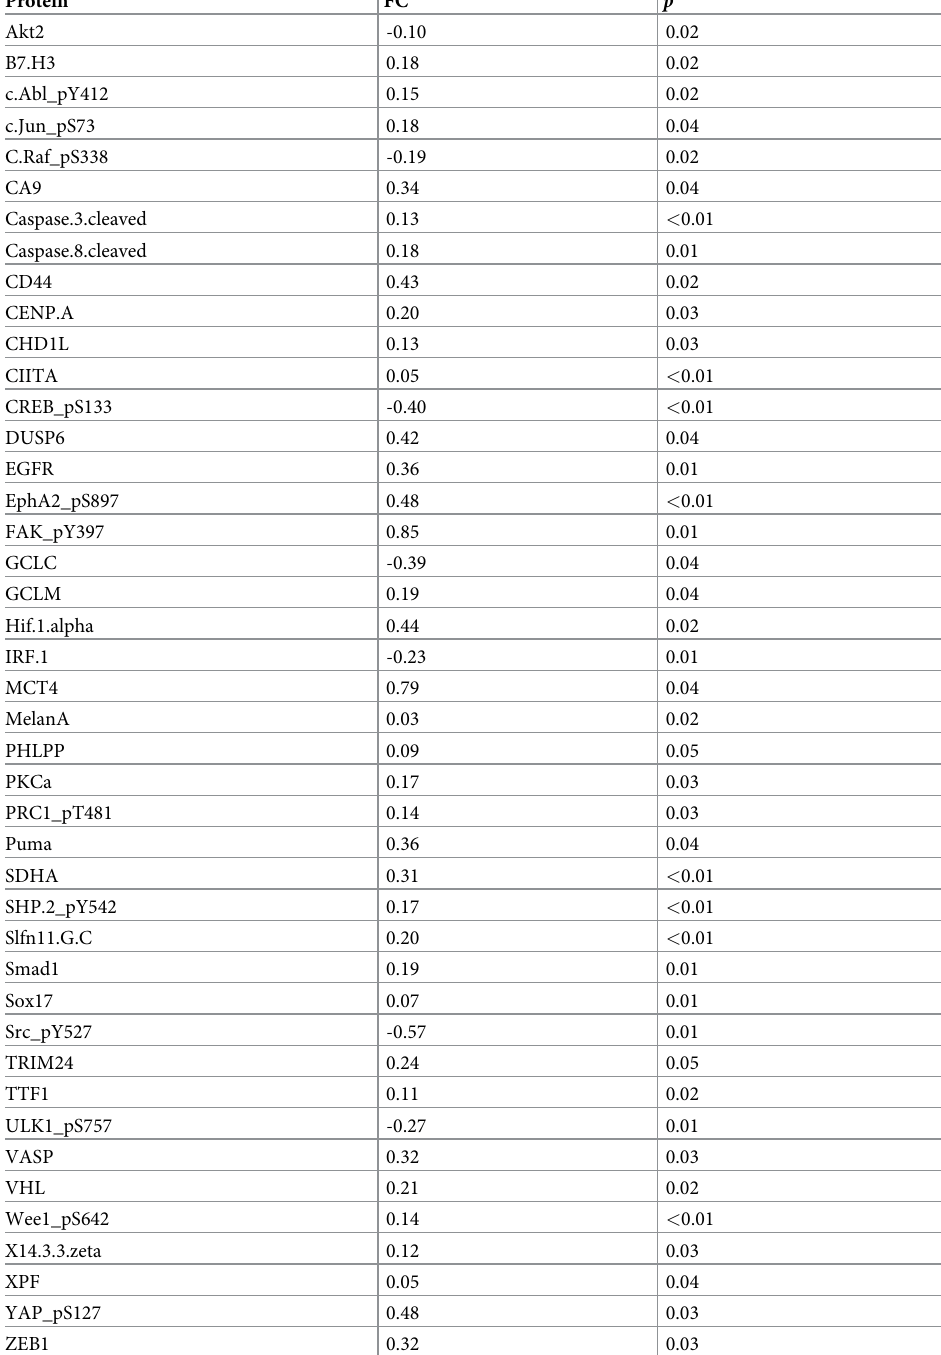
Table 2. Significantly affected proteins by lapatinib and dasatinib in combination vs lapatinib alone in HER2 +